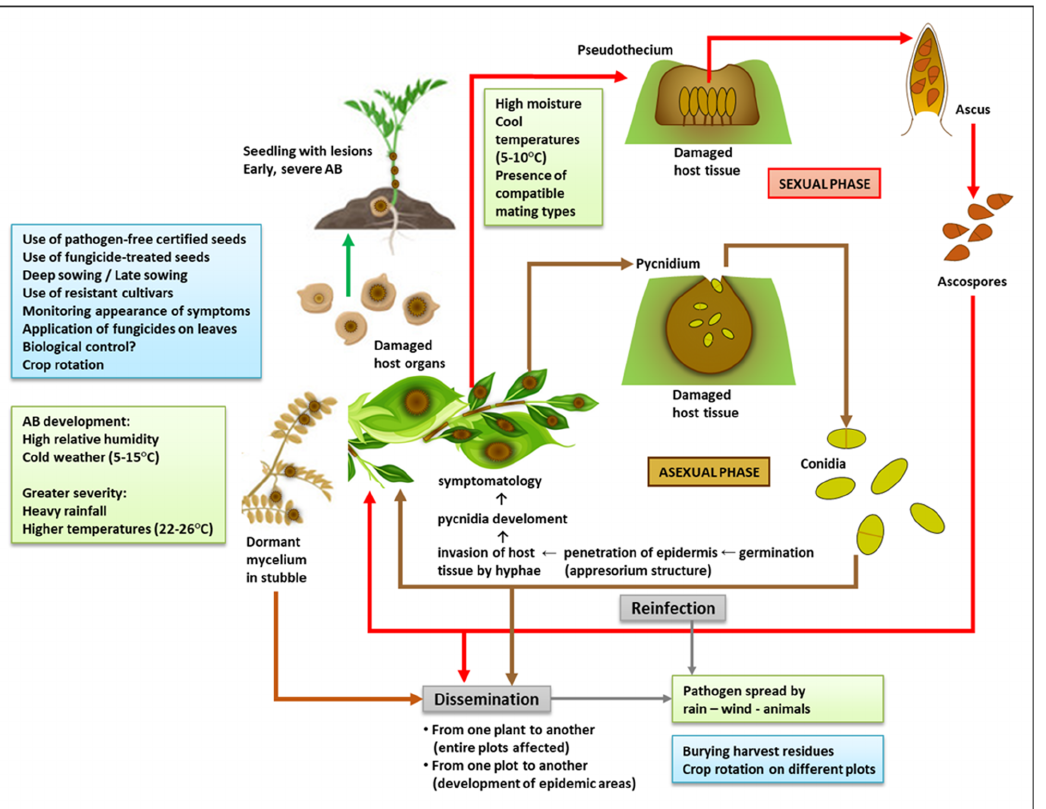
Figure 1. Integrated view of Ascochyta blight (AB) disease: life cycle, predisposing environmental conditions (green boxes), and management practices (light blue boxes). To make this figure, some images were downloaded from https://www.vectorstock.com/royalty-free-vector/green-pod- chickpea-as-annual-legume-plant-vector-31018799 and https://www.vectorstock.com/royalty-free- vector/chickpea-plant-growth-stages-infographic-elements-vector-25494313 (accessed on 5 January 2023).